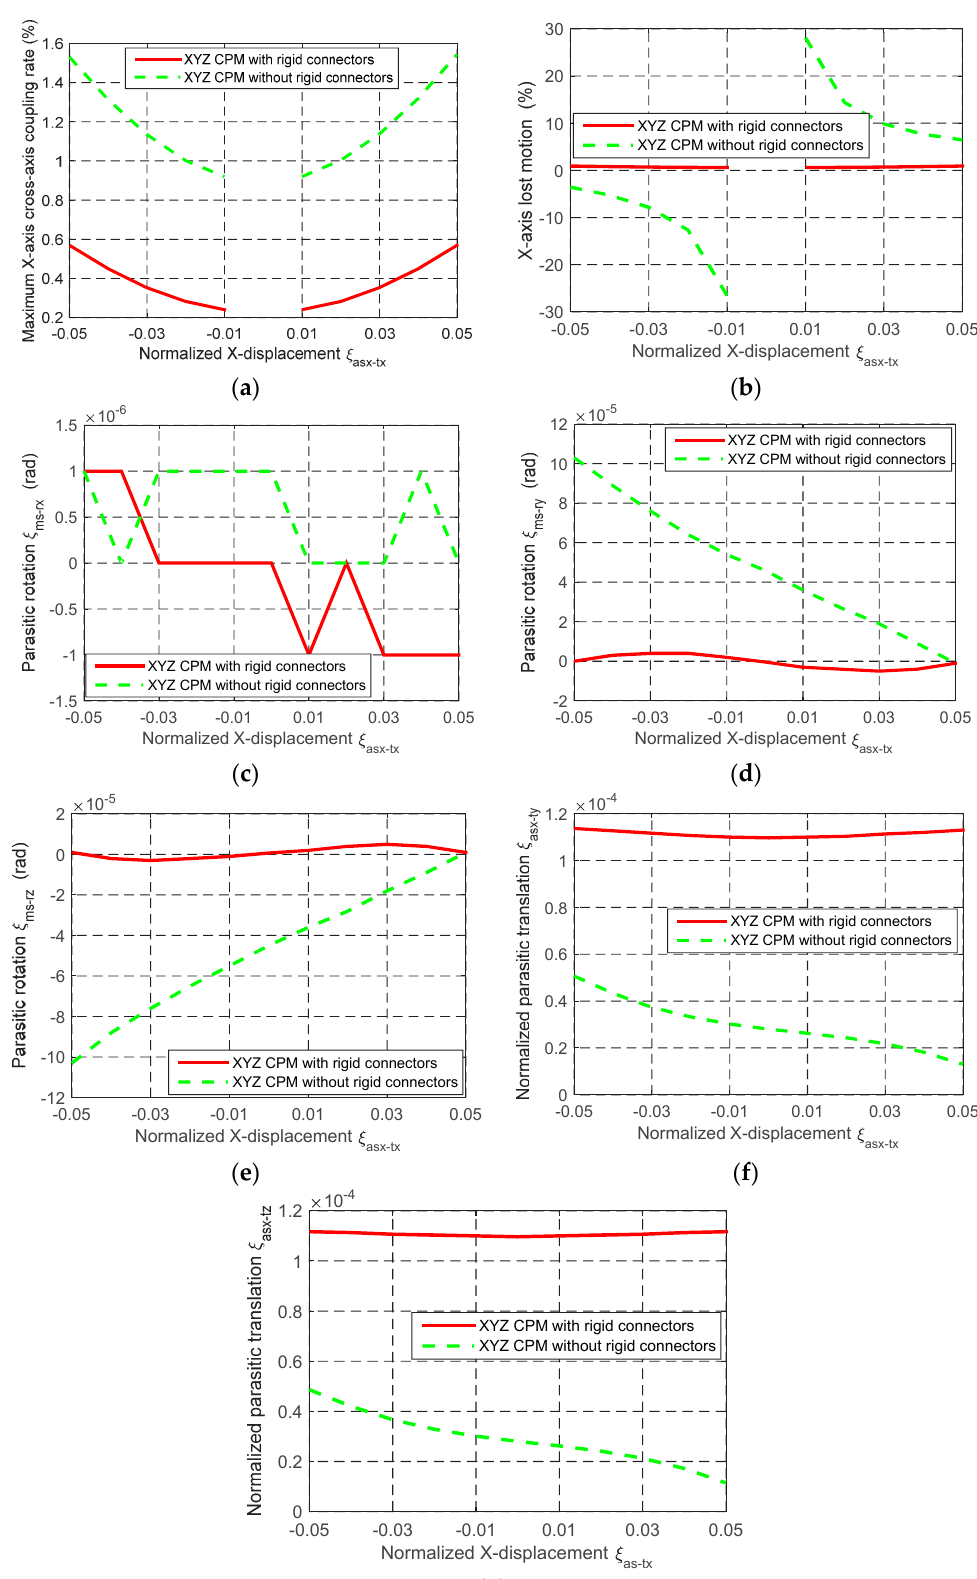
Figure 8. The comparison of the motion characteristics of the two XYZ CPMs with and without the rigid linkages, as shown in Figures 5 and 6, respectively: ( a ) Cross-axis coupling rate in terms of the X-axis primary translation of the MS, ( b ) lost motion rate along the X-axis, ( c – e ) parasitic rotations of the MS about the X-, Y- and Z-axes, respectively and ( f – g ) parasitic translations of the AS along the Y- and Z-axes, respectively.